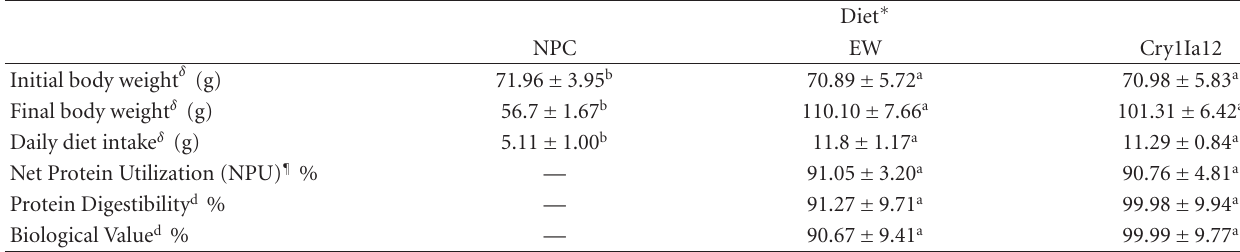
Table 2: Nutritional parameters of rats fed the Cry1Ia12 toxin diet compared to those of rats fed the egg white (EW) and nonprotein (NPC) diets.